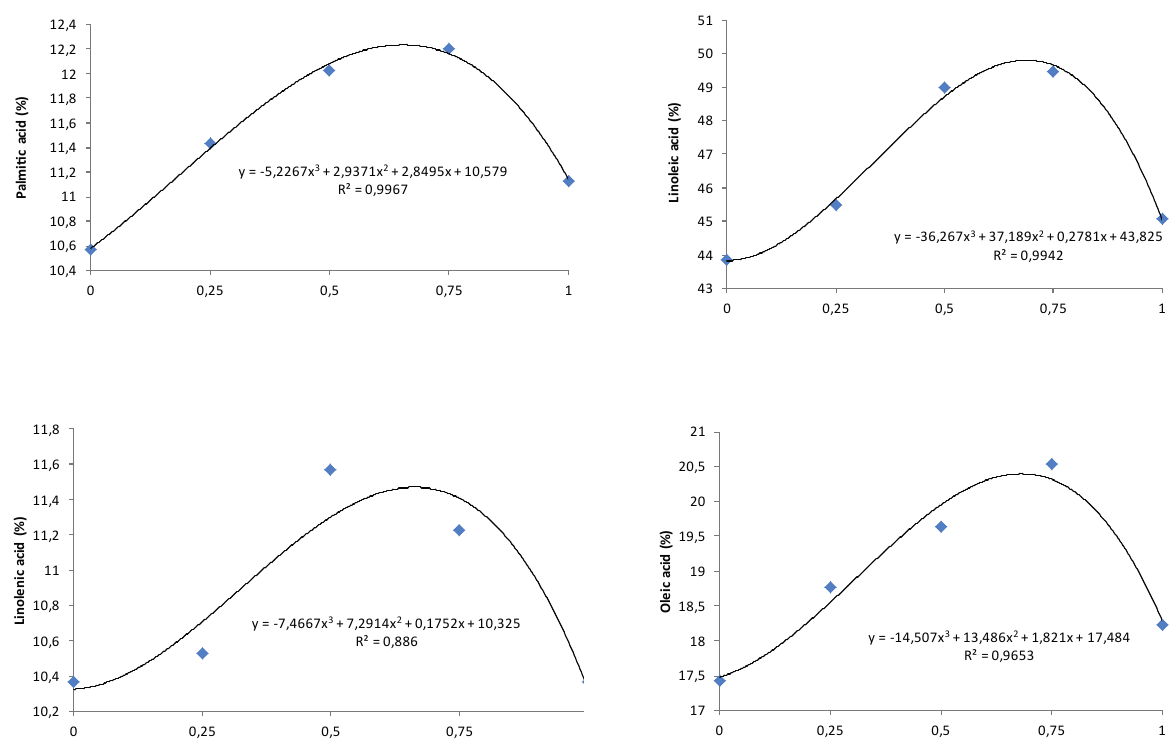
Figure 3 - The effect of different concentrations of nano-iron oxide on soybean seed fatty